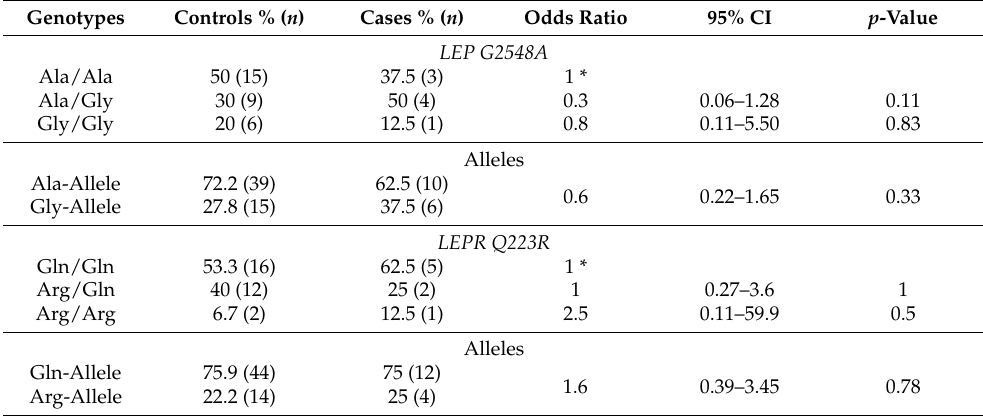
Table 8. Results of G2548A LEP and Q223A LEPR of controls and Group 3 cases with normal BMI and abnormal sleeping, eating, and stress